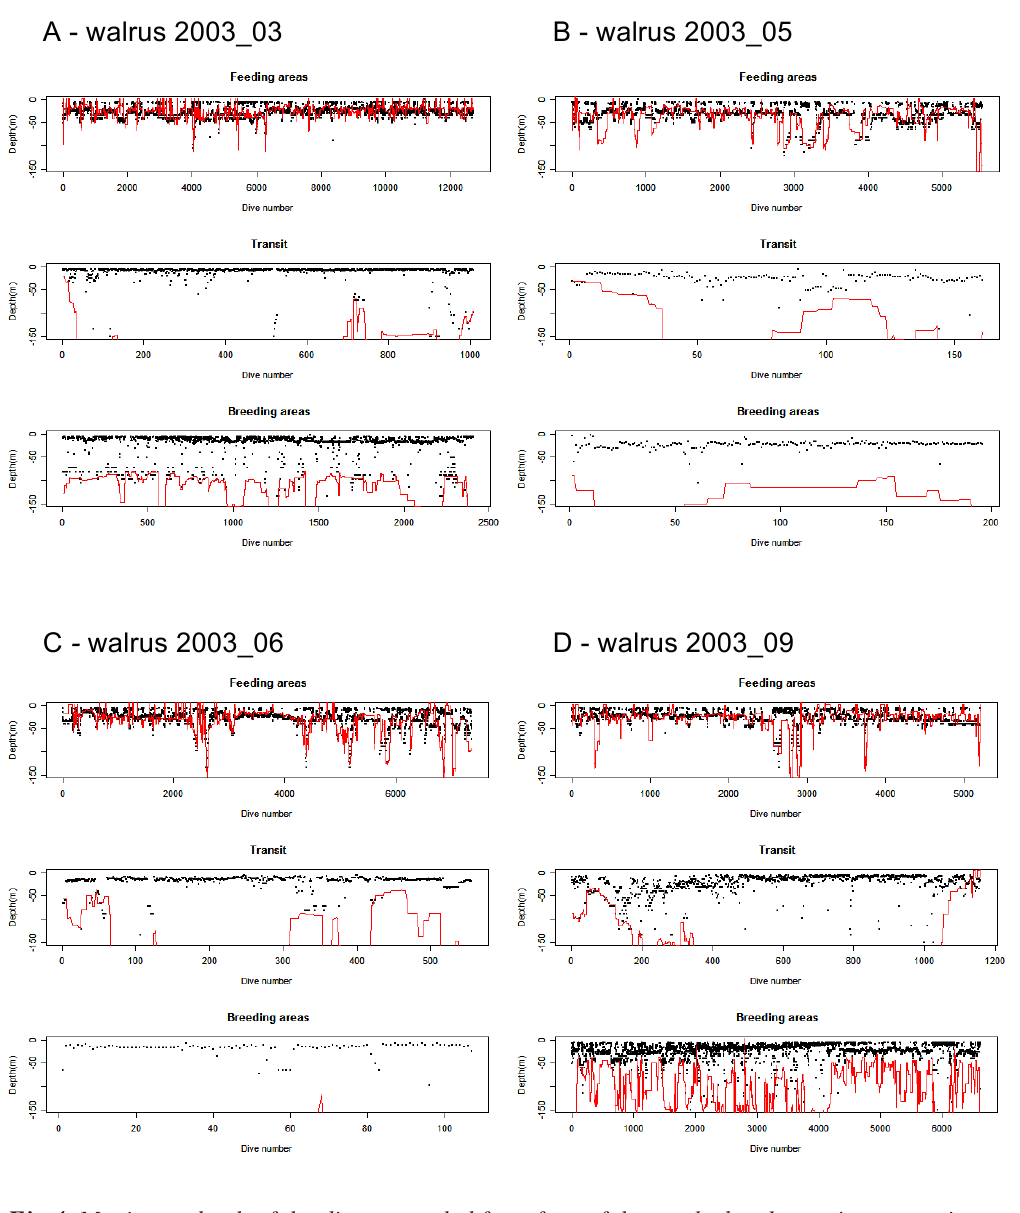
Fig 4. Maximum depth of the dives recorded from four of the tracked walruses in summering areas, wintering areas and during transit between these areas. Sea bottom depth (≤150 m) is also shown (red line; From Freitas et al.